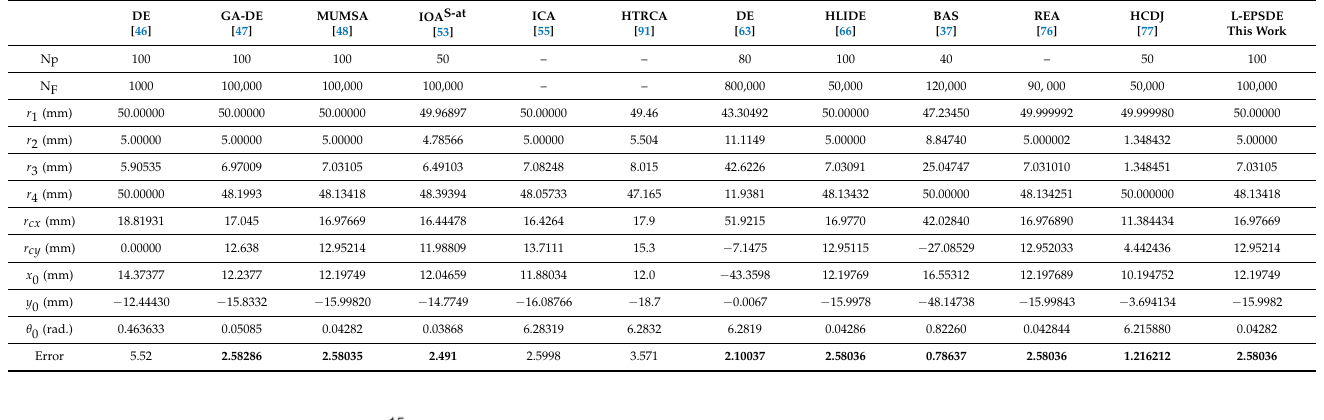
Figure 15. The convergence rates of the five metaheuristic methods are shown in Figure 16, which indicated that the convergence rate of L-EPSDE was faster than those of PSO, EPSDE, and HPSO, but was slightly slower than DE-gr. Table 5. Optimal results of L-EPSDE and eleven other optimization methods for Case 3.